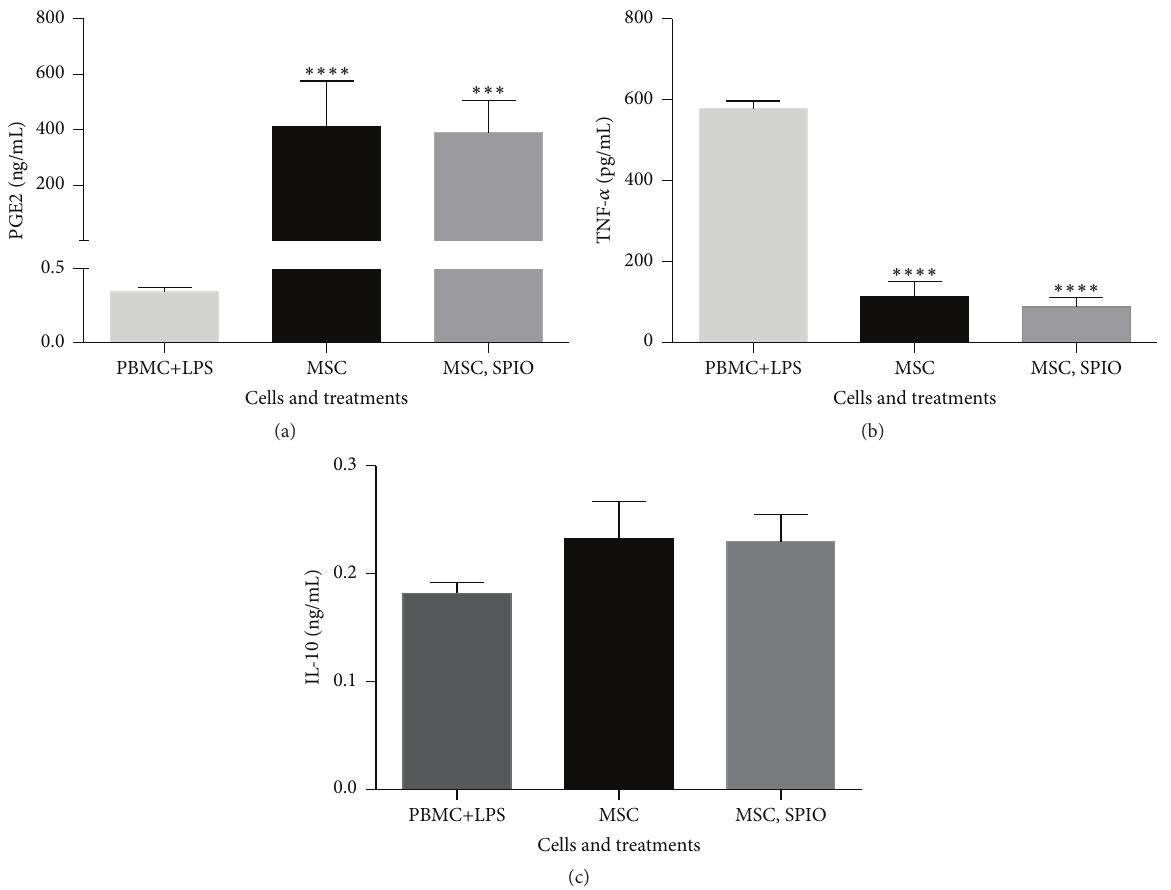
Figure 5: Graphs representative of (a) prostaglandin-E2 (PG-E2), (b) tumor necrosis factor- 𝛼 (TNF- 𝛼 ), and (c) interleukin-10 (IL-10) production in MSC coculture with peripheral blood mononuclear cells (PBMCs) following stimulation with LPS ( ∗∗∗∗ 𝑝 < 0.0001 , ∗∗∗ 𝑝 < 0.01